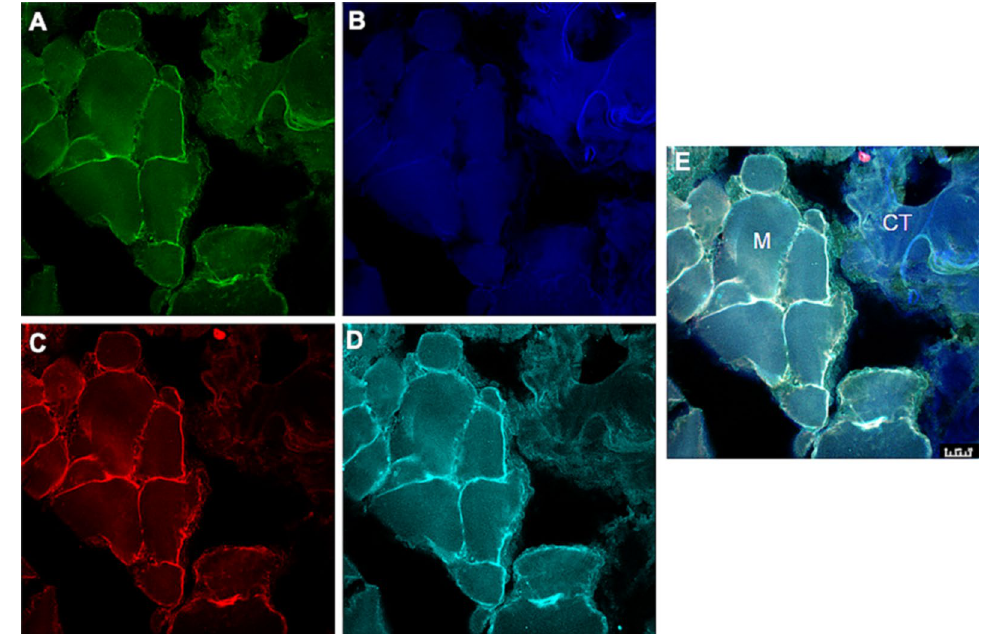
Figure 1. Figure displaying an example of the photomicrographs used for the analysis. The high power (×40) photomicrographs show fluorescent signaling of ( A ) PGP 9.5, ( B ) substance P, ( C ) NMDA-receptor 2B and ( D )